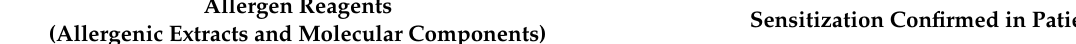
Table 2. The order of allergen reagents (allergenic extracts and molecular components) according to the frequency of sensitization in 100 atopic dermatitis patients (=100%). We show the sensitization to allergens reagents, which has been recorded in more than 10% of